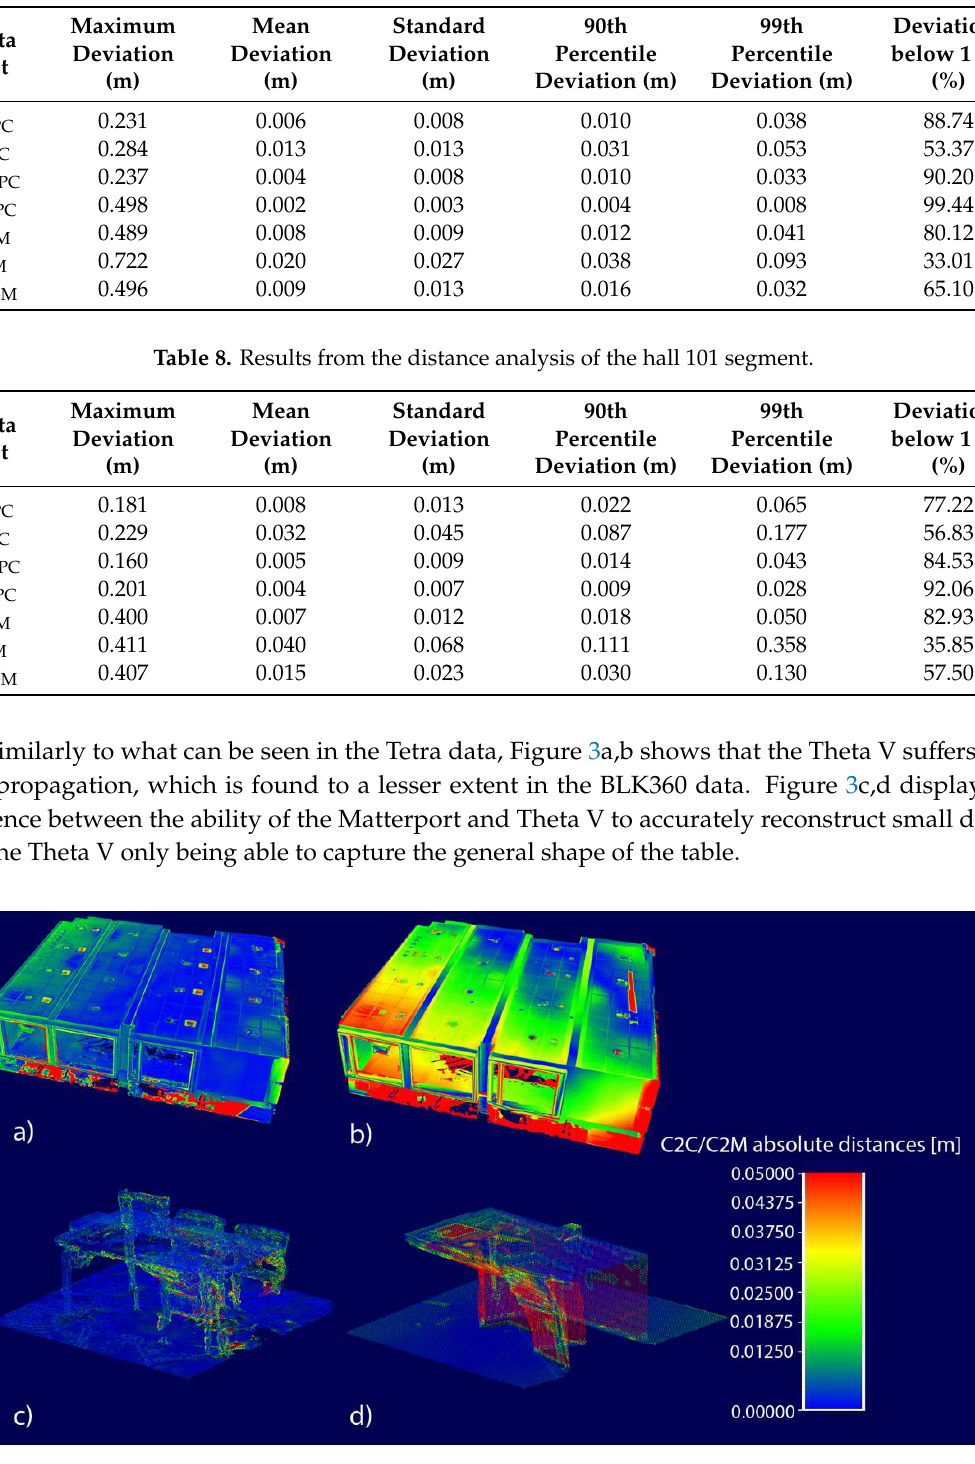
Table 7. Results from the distance analysis of the hall 101 room geometry.